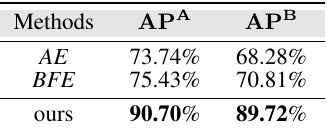
Table 3. The performance of the clustering algorithms. AE is short for Associative Embedding and BFE is short for Brute Force Enumeration algorithm.